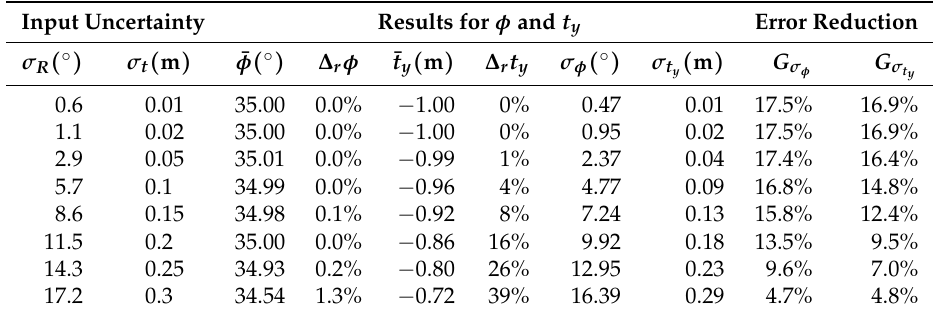
Table 4. Summary of uncertainty propagation when using 5 paths with Gaussian PDF for input uncertainties in the MCS analysis. Example for two variables φ and t y . The last two columns in the table show the gains in error reduction by using the multi pairwise approach.